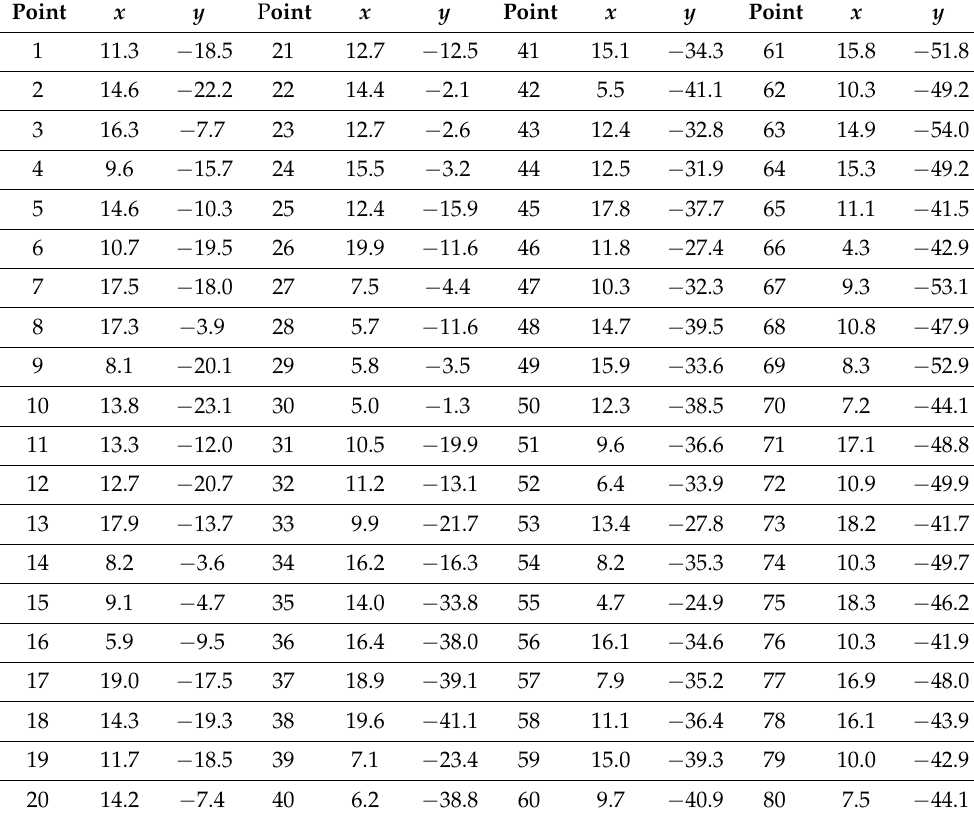
Table A1. Cartesian coordinates of the spatially random distributed spheres that represents the source points of convective heat loss from the cows, without mass and without presenting any resistance in the air